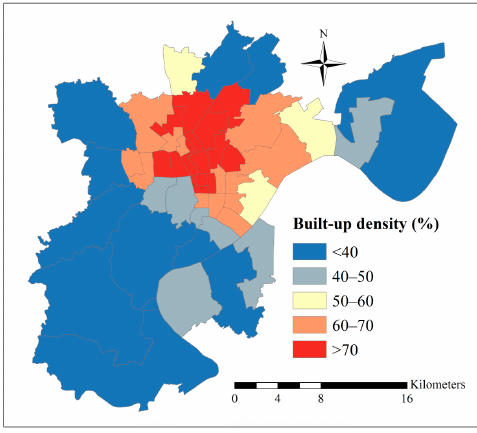
Figure 5. Built-up density for street-town unit.